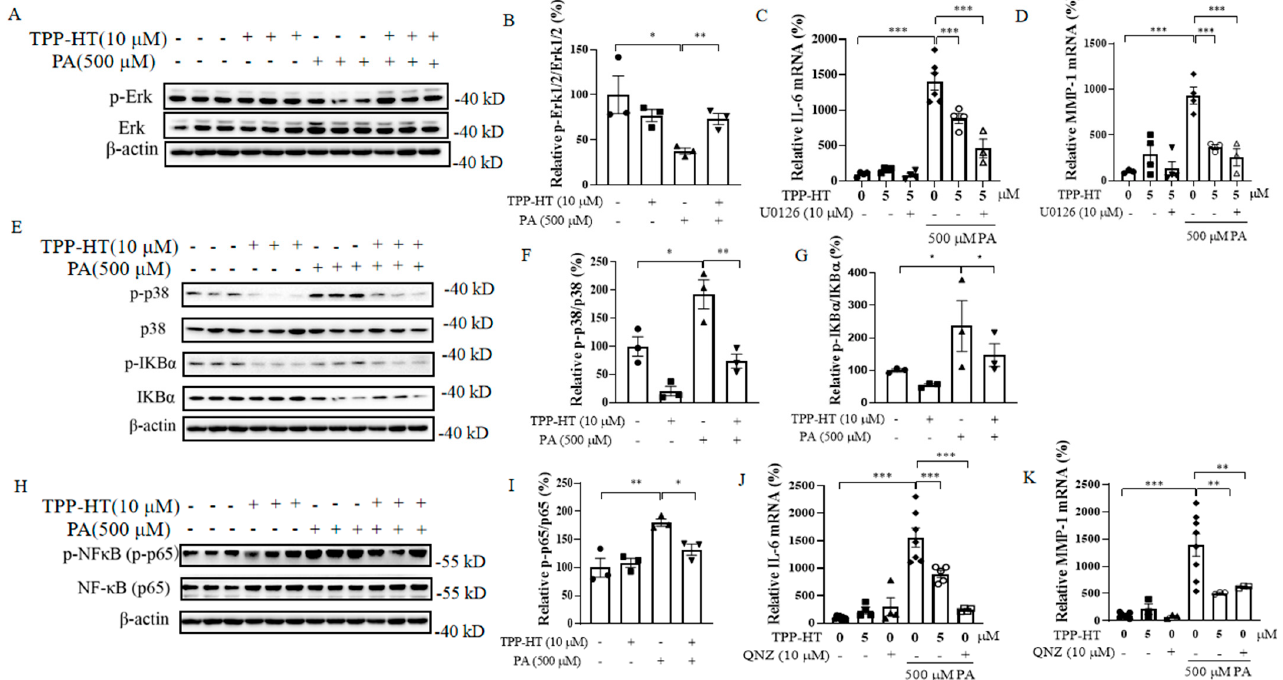
Figure 7. TPP-HT pretreatment abrogates PA-induced IL-6 and MMP-1 mRNA production by inhibiting the p38/NF- к B signaling pathway in HAECs. HAECs were treated with TPP-HT at 10 μ M for 24 h, followed by 500 μ M PA challenge for 24 h. HAECs were treated with TPP-HT (10 μ M) for 24 h in the absence or presence of Erk inhibitor U0126 (10 μ M) or NF- к B inhibitor QNZ (10 μ M) pretreatment, followed by PA (500 μ M) challenge for another 24 h. ( A ) Protein levels of p-Erk, Erk.